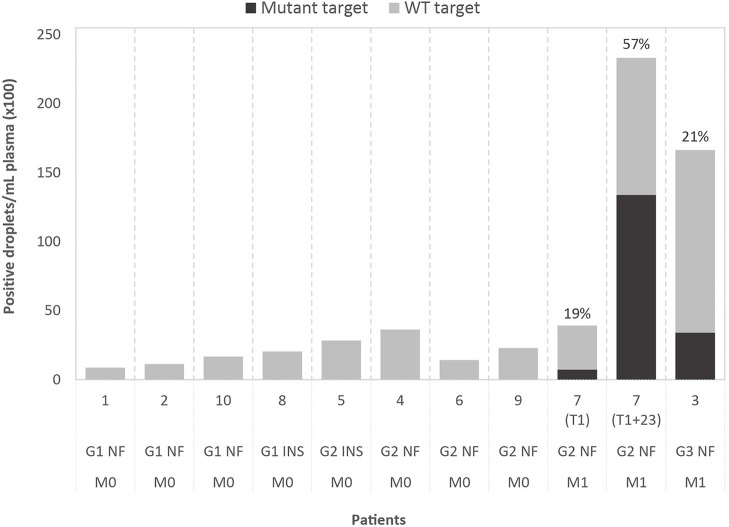
Results of droplet digital PCR (ddPCR) on cell-free DNA of ten patients, grouped by WHO2010 grade (G), functionality of the tumor (NF, non-functional; INS, insulinoma) and presence of metastasis (M0, no metastasis; M1, metastasis present). The graph shows the number of positive droplets per 1 mL of plasma, for both mutant (black) and wild-type (WT; gray) target. For mutant-positive patients, the variant allele fractions (VAFs) are indicated. The selected ddPCR targets are, from left to right, chr3:g.98251584T>A (GPR15), chr2:g.46603856C>T (EPAS1), chr21:g.39754856C>A (ERG), chr20:g.46288182C>T (SULF2), chr5:169477296C>T (DOCK2), chr2:g.111416130T>G (BUB1), chr2:g.204073466C>G (NBEAL1), chr16:g.15854467G>A (MYH11), chr11:g.64575561C>A (MEN1), chr6:g.33288573G>A (DAXX) (in GRCh37/hg19). For case 7, results obtained with the same ddPCR assay are shown for the perioperative plasma sample (T1) and the follow-up plasma sample (T1+23 months).